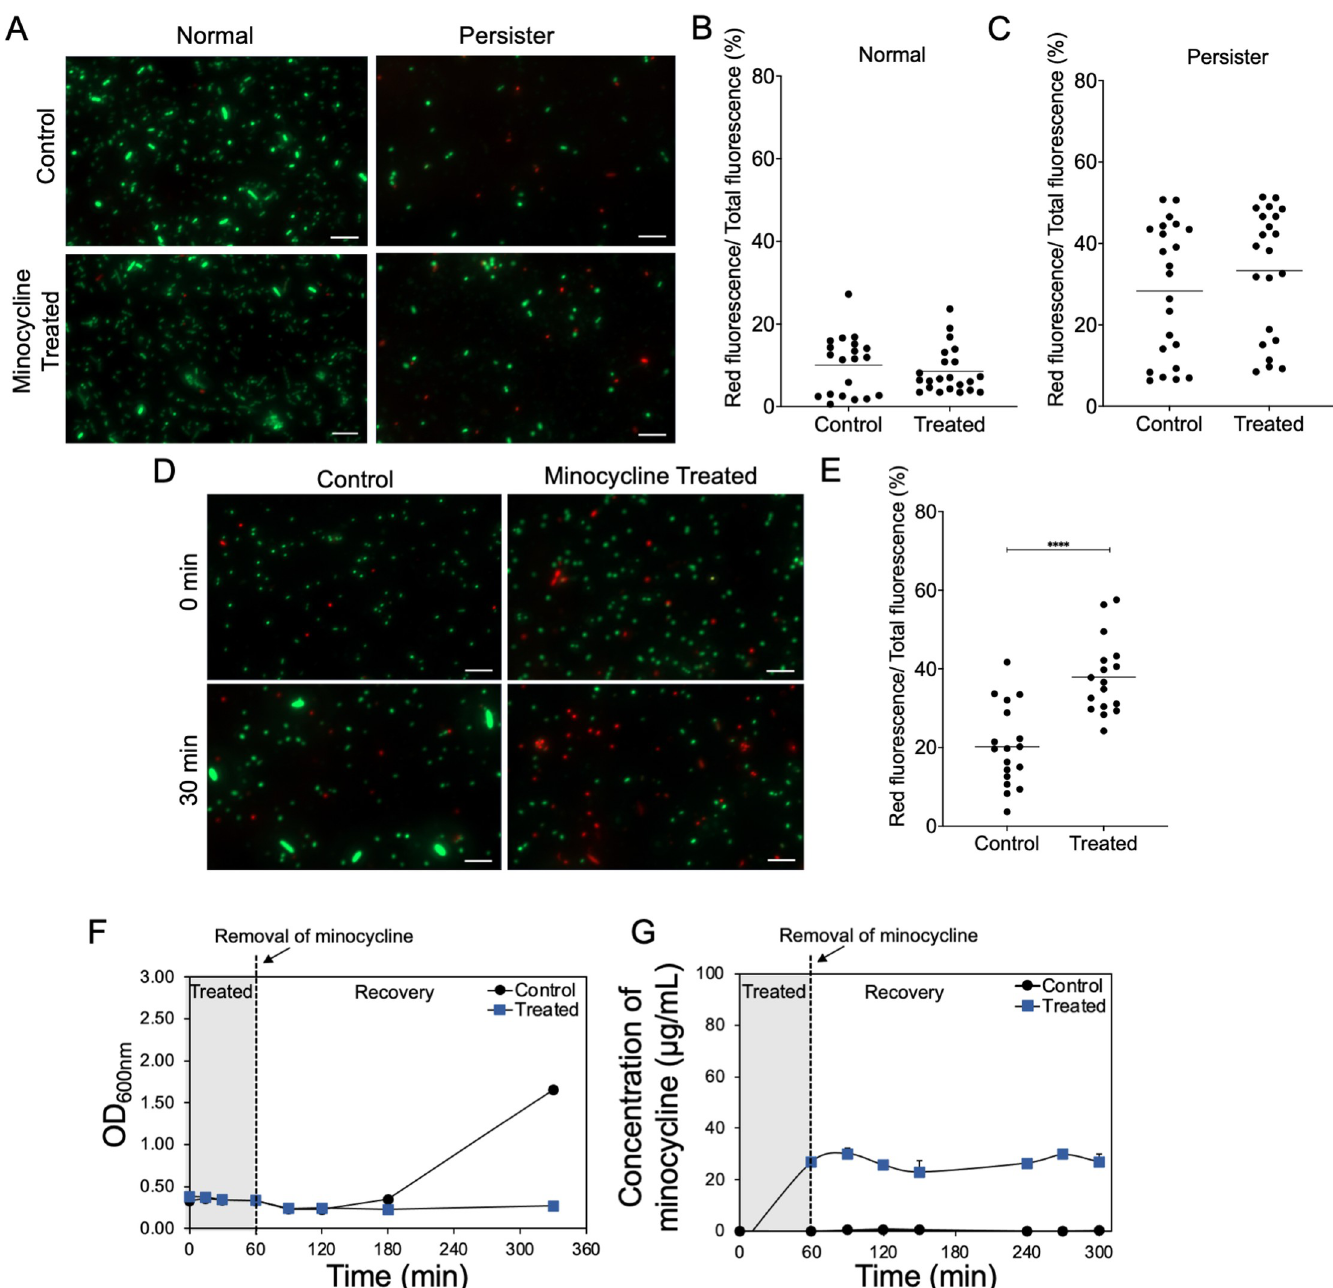
Fig 4. Killing occurred upon wake-up of persister cells. (A) Representative fluorescence images of control and minocycline treated E . coli HM22 normal and persister cells after LIVE/DEAD staining (scale bar = 10 μ m). Fluorescence signals were used to compare the viability of normal (B) and persister (C) cells. Mean fluorescence intensity of SYTO9 and PI was quantified using ImageJ. (D) Representative fluorescence images of persister cells upon wake-up after minocycline treatment. The images show persister and normal cells at 0 and 30 min after spiking with LB medium. (E) Fluorescence signals of LB spiked E . coli HM22 persister cells. Three biological replicates were tested with 16 images randomly analyzed from each sample. (F) OD 600 of E . coli HM22 persister cells during wake-up. Cells with and without minocycline treatment were compared. (G) Intracellular concentration of minocycline after minocycline was removed from the solution and replaced with LB medium. � p -value � 0.05, �� p -value � 0.01, ��� p -value � 0.001, ���� p -value � 0.0001.